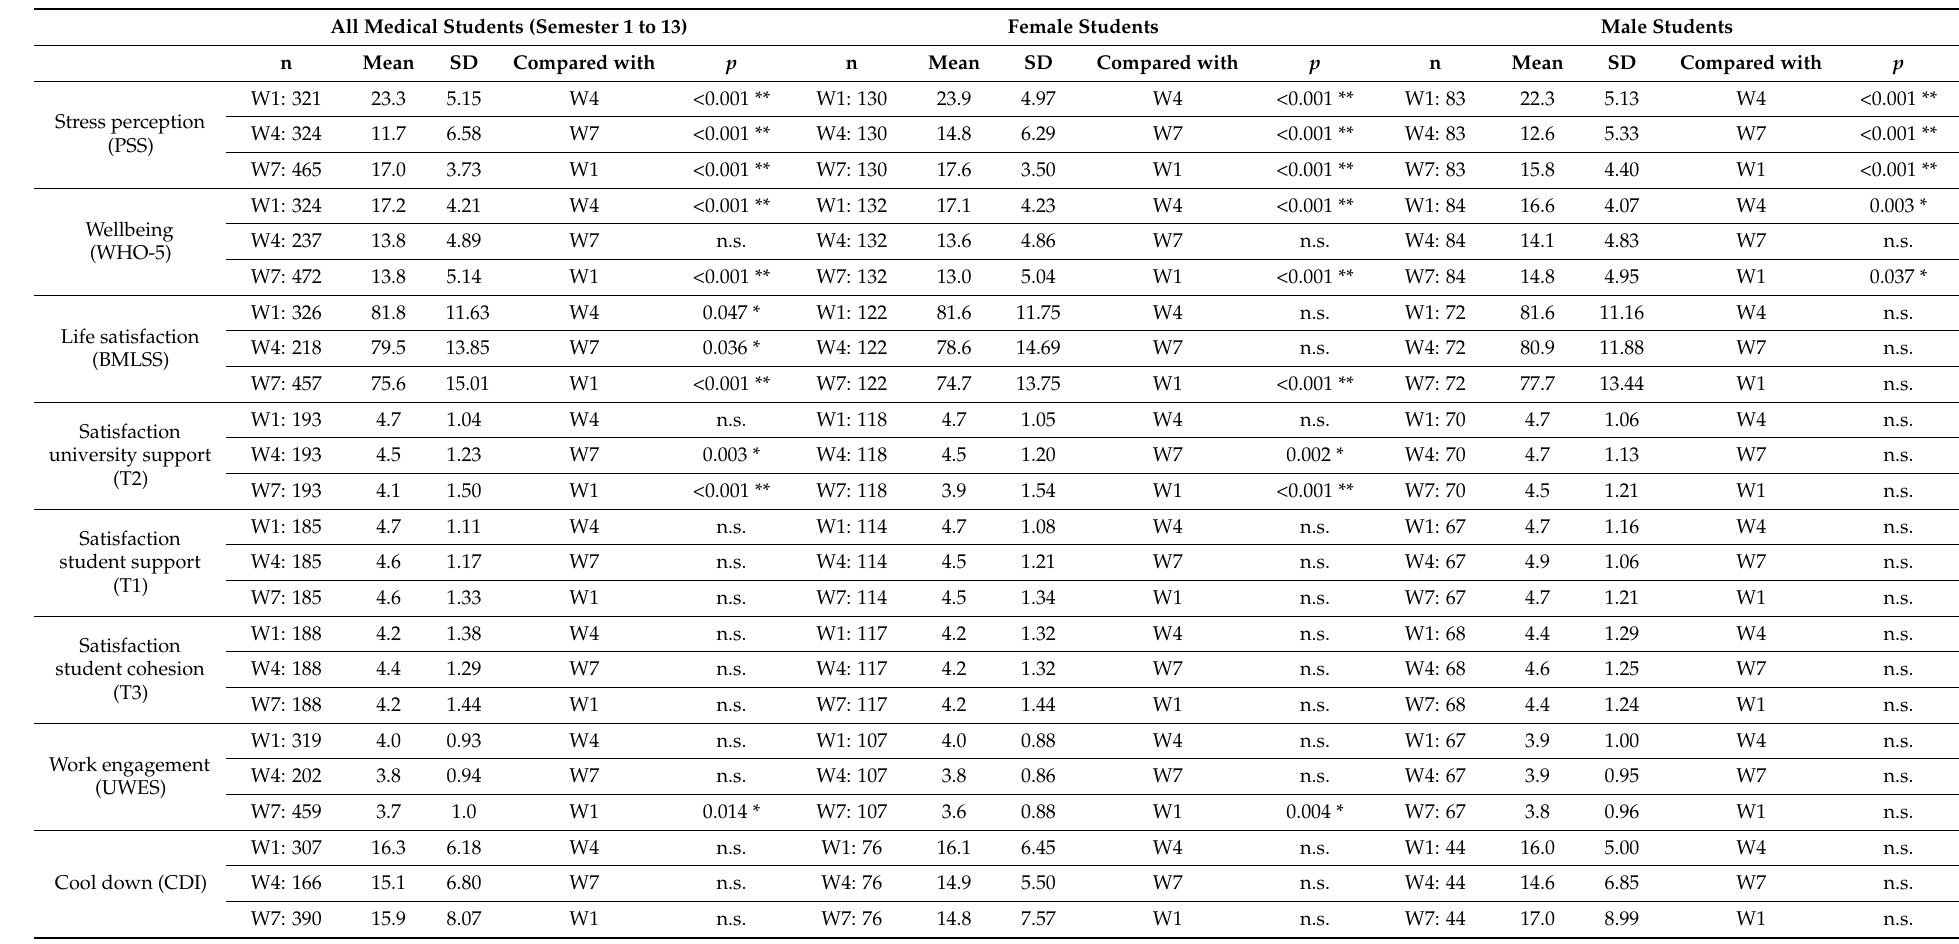
Table 3. Indicators of stress and wellbeing in medical students of waves 1, 4 and 7 differentiated for gender. All Medical Students (Semester 1 to 13) Female